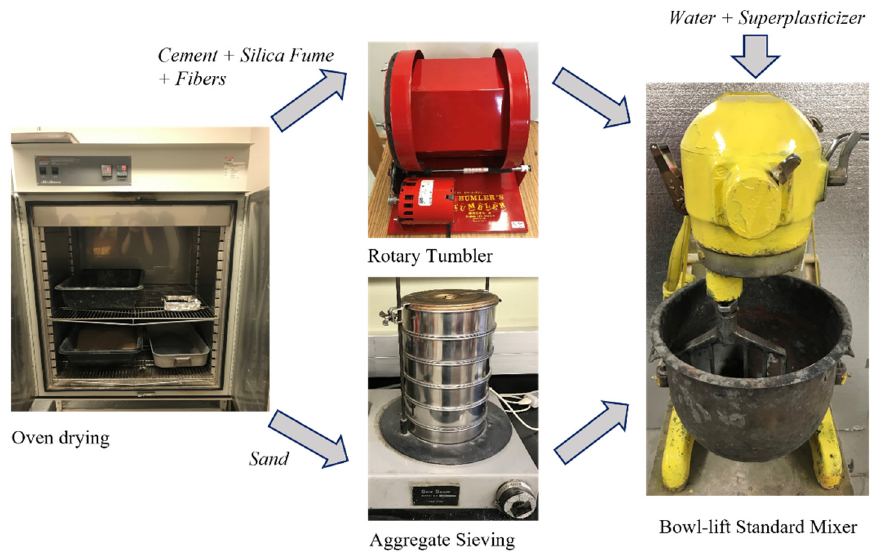
Figure 2. Mixing protocol schematic.